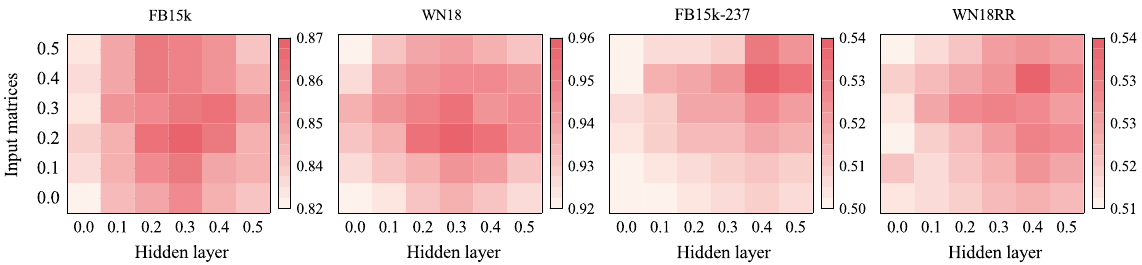
Figure 5. The Hits@10 performance with various dropout rates for four